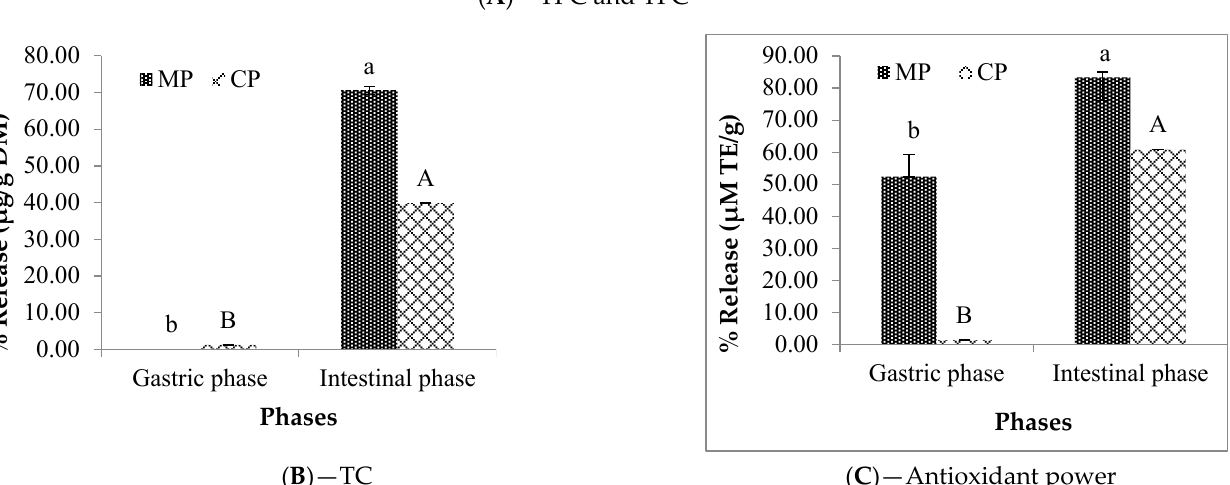
Figure 5. TPC, TFC ( A ), TC ( B ), and antioxidant activity ( C ) release (%) after 2 h of in vitro gastric and intestinal digestion of Balanites aegyptiaca crude and microencapsulated extracts. MP: Microencapsulated powder; CP: Crude powder; TPC: Total polyphenolic contents; TFC: Total flavonoid contents; TC: Total carotenoids. For each biocompound, the gastric phase averages that do not share any lower ‐ case letters are significantly different at the 0.05 threshold; the same applies to the averages of the intestinal phase that do not share any upper ‐ case letters.